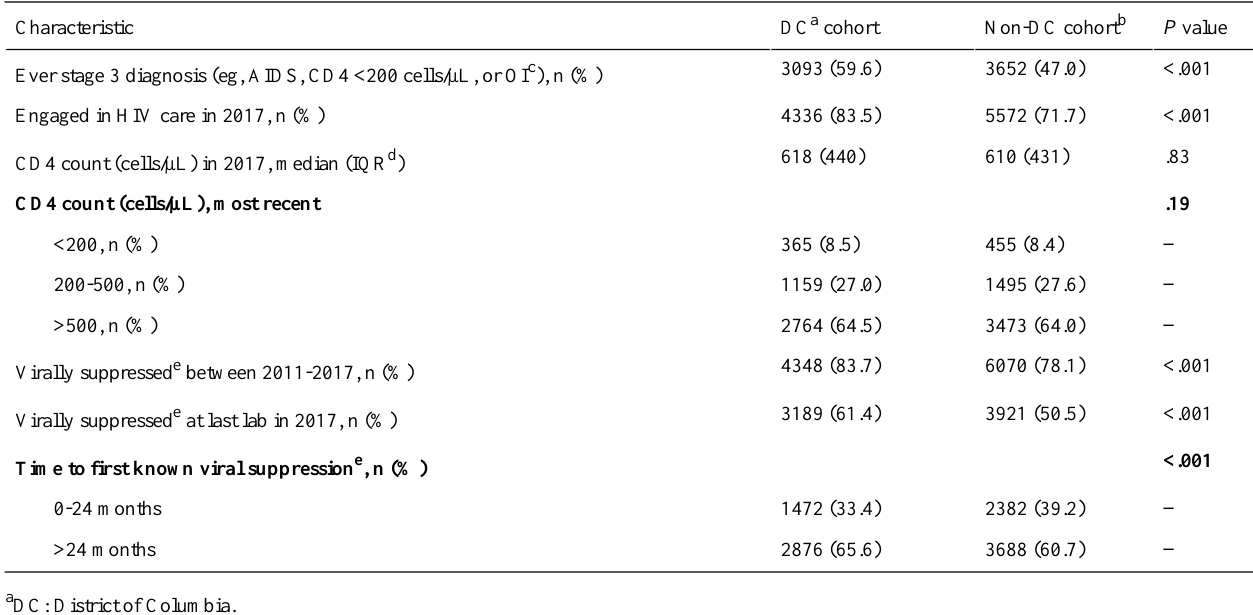
Table 3. Clinical characteristics of DC Cohort and non-DC cohort participants living in DC as of December 2017 (n=12,964).